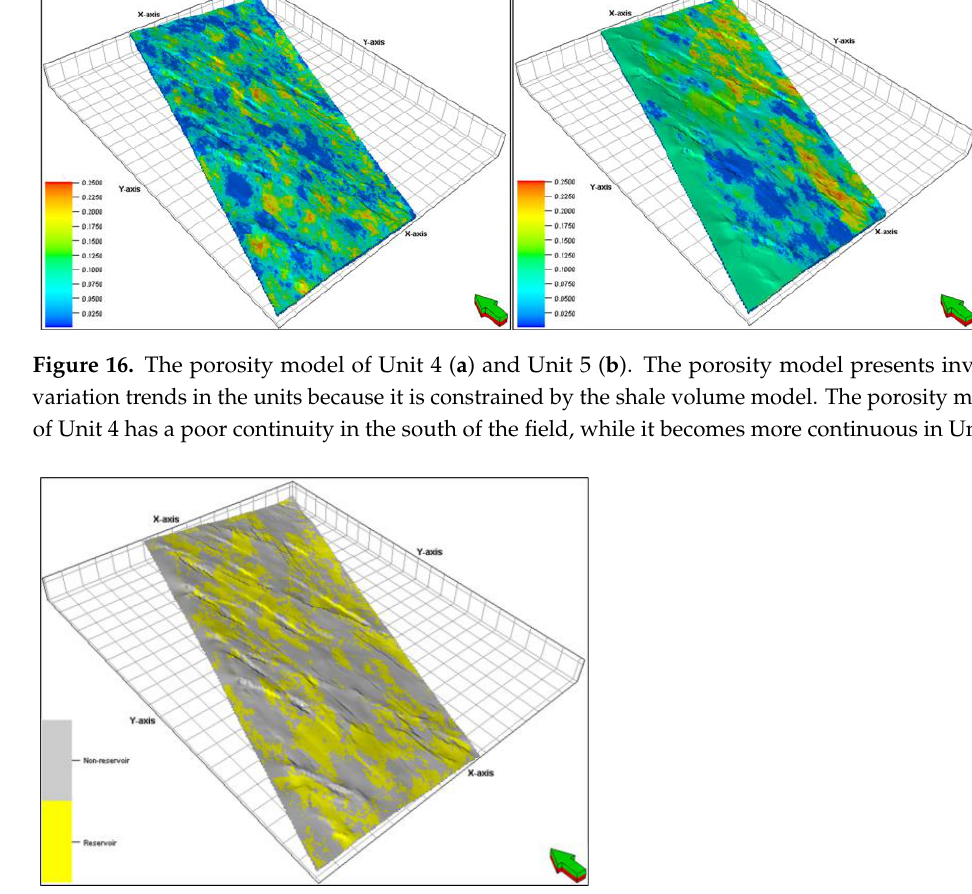
Figure 17. The discrete reservoir trend generated by a cutoff value of 40% of shale volume. It is used to constrain the discrete rock type model.